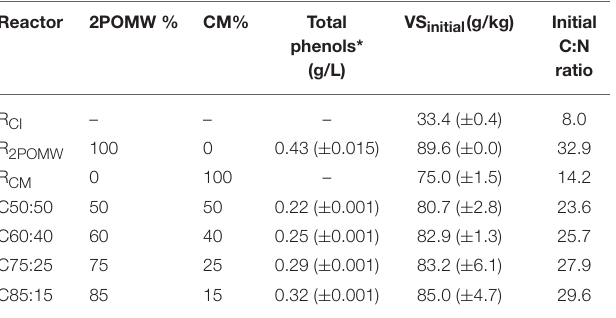
TABLE 2 | Compositions of co-digestion (C50:50, C60:40, C75:25, and C85:15) and biodegradability (R 2POMW , R CM and R CI ) reactors.